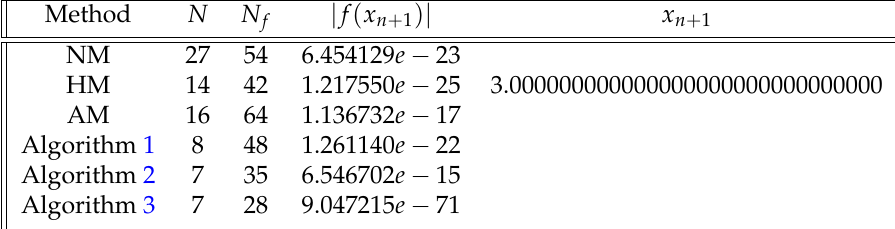
Table 3. Comparison of NM, HM, AM and Algorithms (1), (2) and (3)